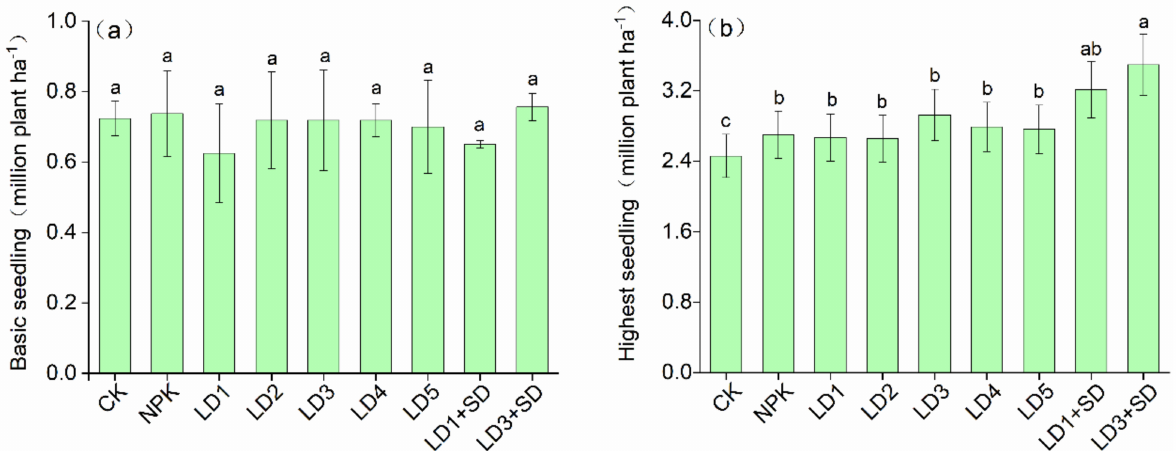
Figure 2. The basic ( a ) and the highest ( b ) seedlings under different treatments, respectively. The values are means with standard error bars. Different letters above the bars indicate significant differences at the 5% level.